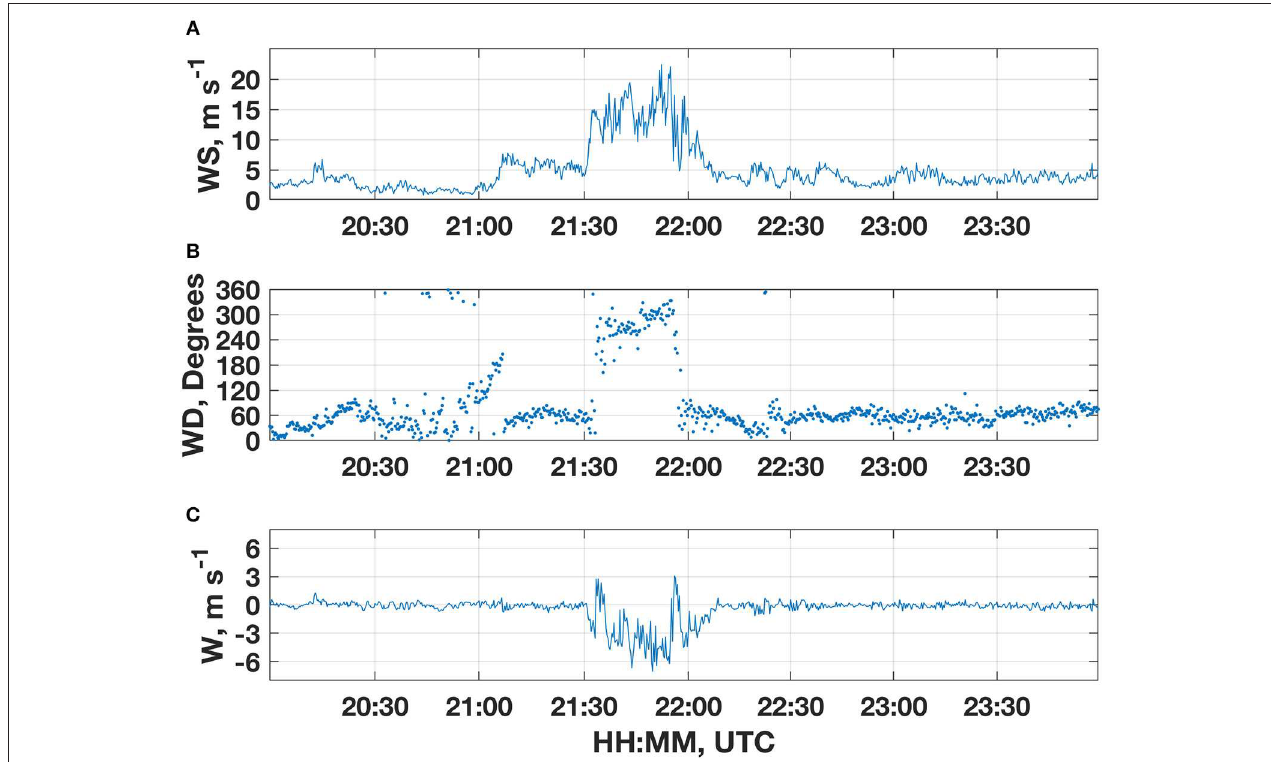
FIGURE 2 | Time series of the 29m (A) horizontal velocity, (B) wind direction, and (C) vertical velocity measured by the ZephIR lidar during the 3 July 2017 thunderstorm